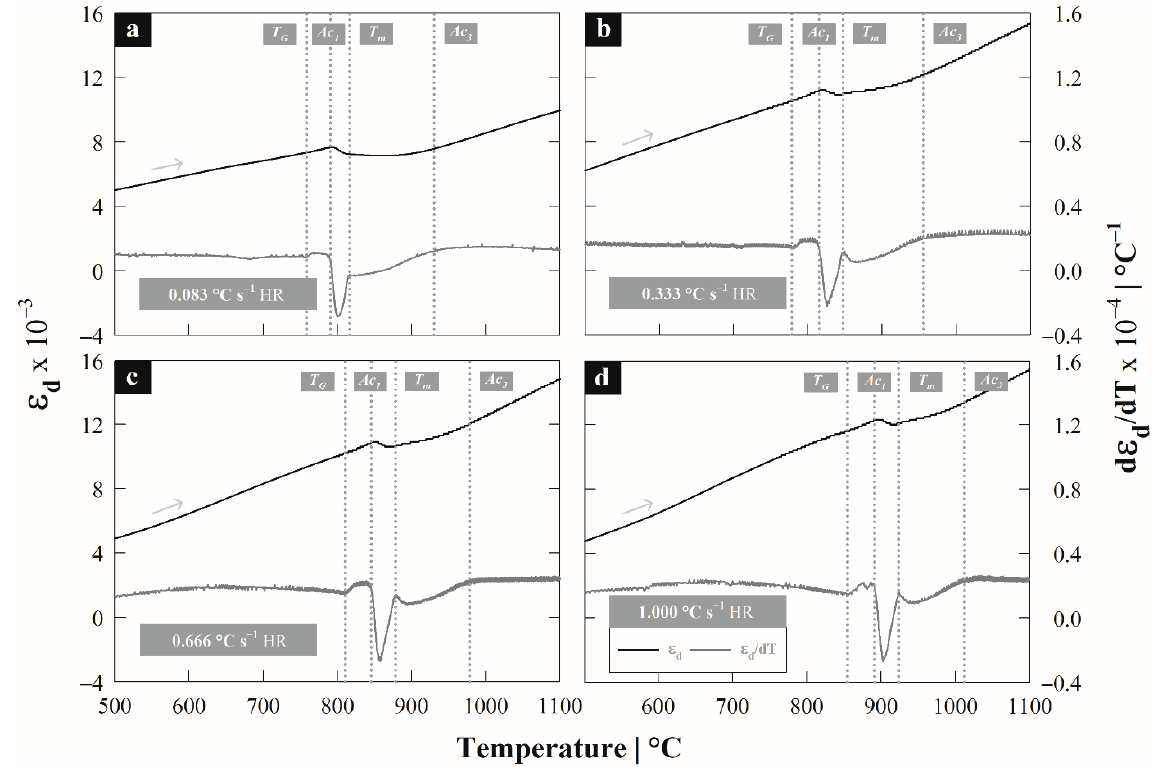
Figure 2. Dilatometric curves for 2.6Si Steel at different heating rates: ( a ) 0.08, ( b ) 0.33, ( c ) 0.66 y ( d ) 1.00 °C s − 1 .